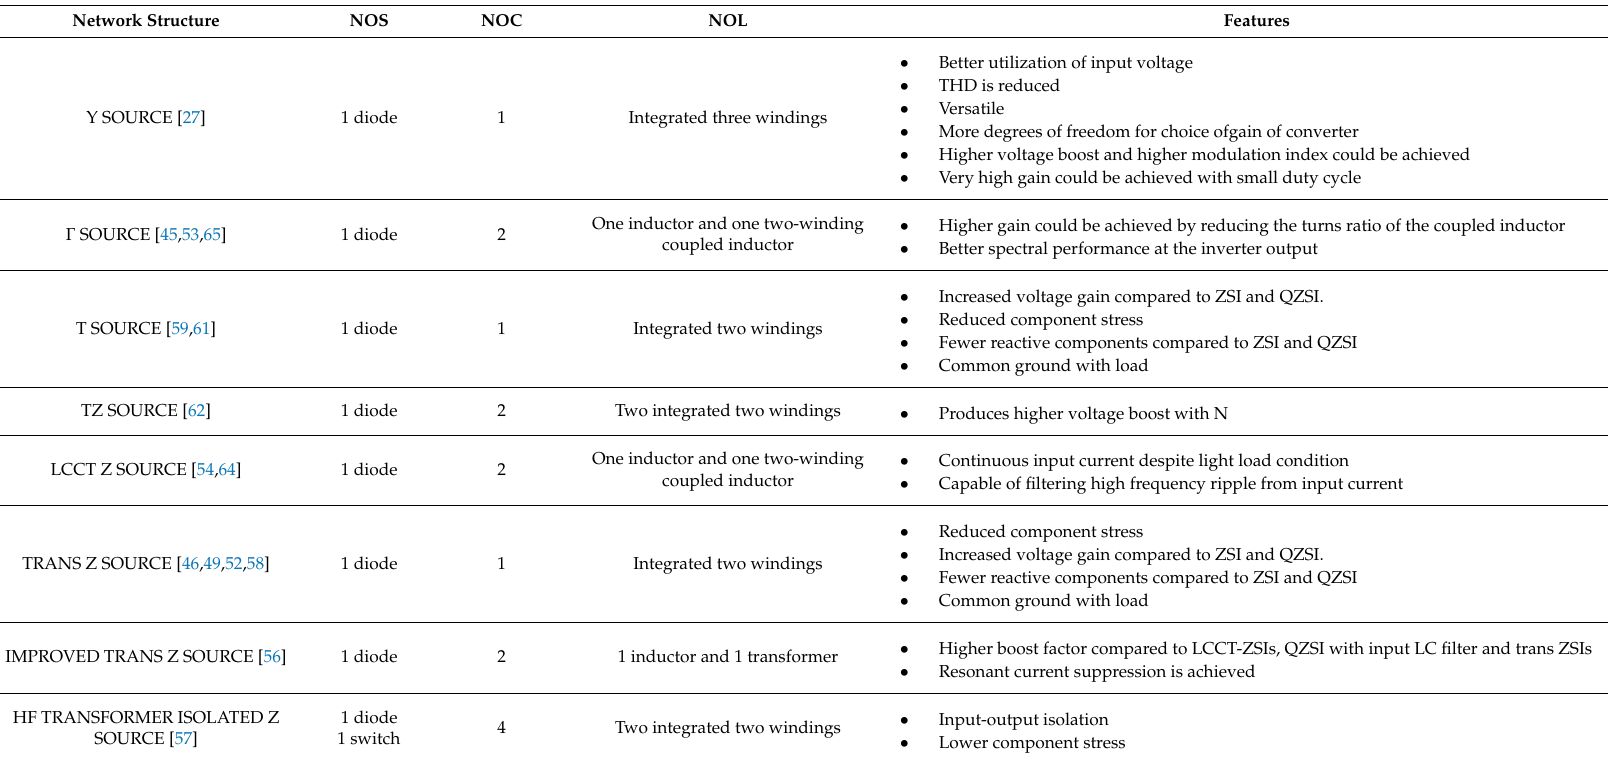
Table 4. State of art PV grid inverter topologies of Z source networks with transformer / coupled